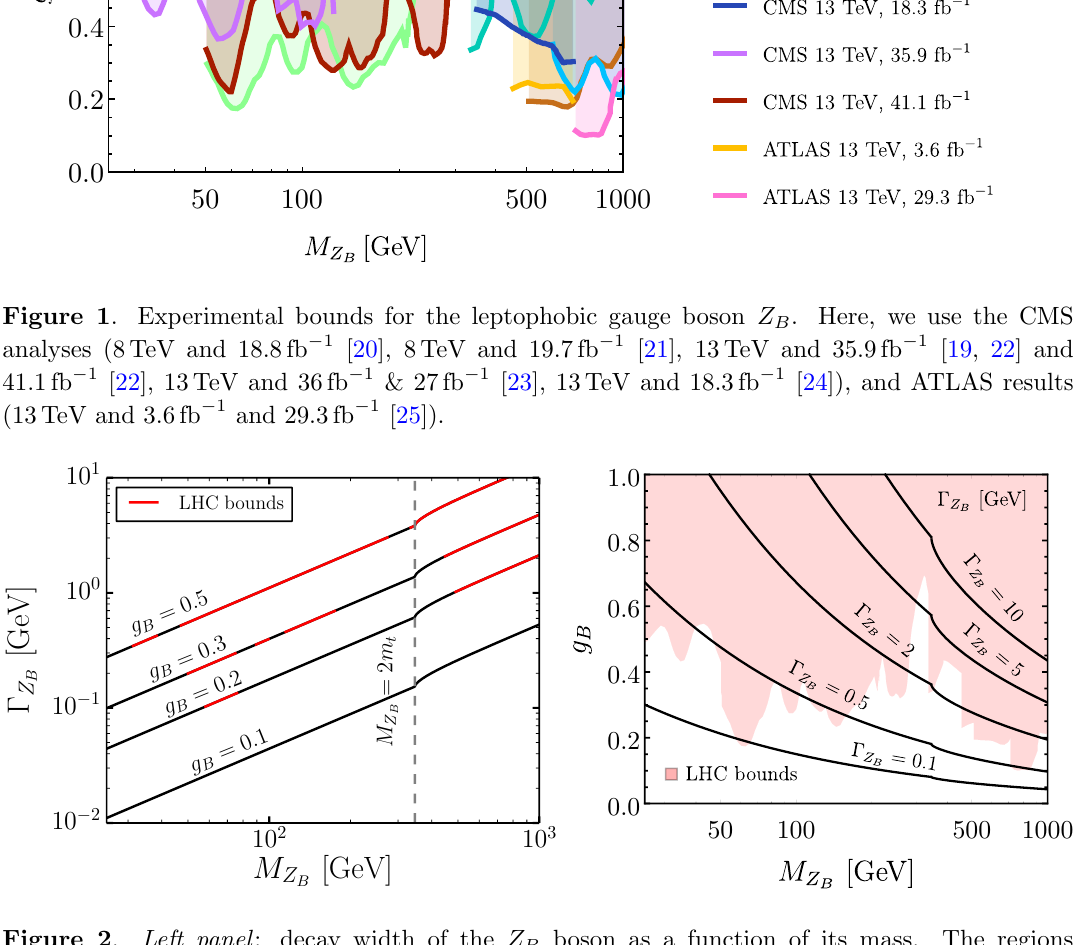
Figure 2 . Left panel : decay width of the Z B boson as a function of its mass. The regions highlighted in red are excluded by searches at the LHC. To the right of the dashed vertical line the decay channel Z B t (cid:22) t is open. Right panel : contour lines for the decay width of the Z B boson in ! the g B vs. M Z B